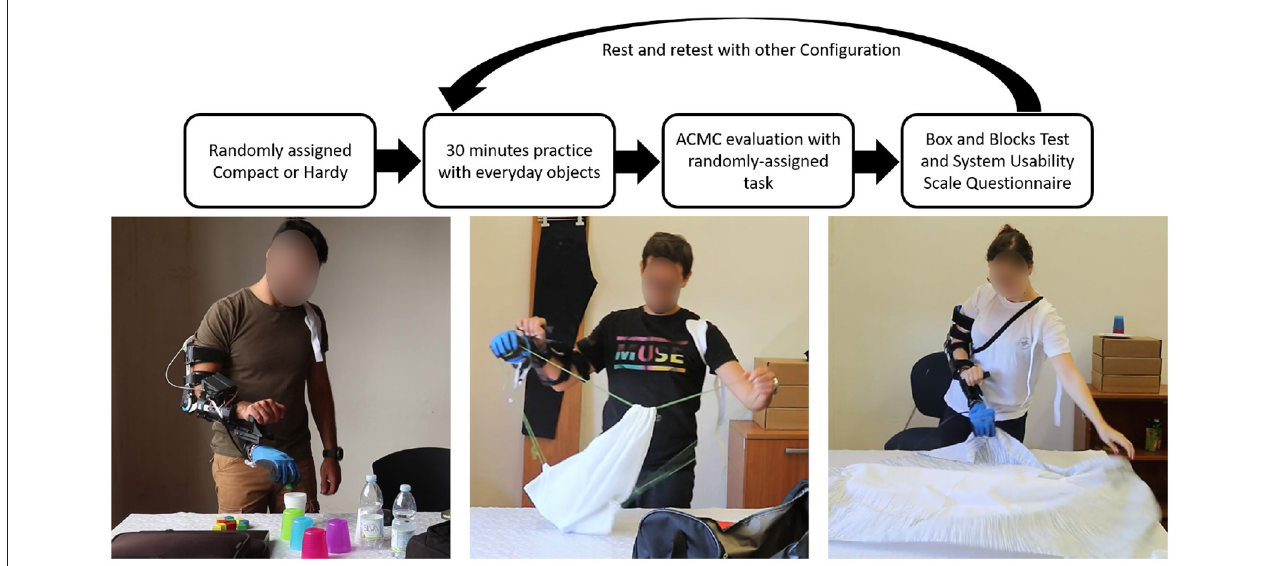
FIGURE 5 | Top : Flow-chart of the experimental protocol. Bottom : Intact-limb subjects practicing with everyday objects (left) and testing the two Hybrid Configurations during tasks of daily living as part of a standardized clinical test: SHPH-C, ACMC “packing” task (middle) and SHPH-H, ACMC “setting the table” task (right).